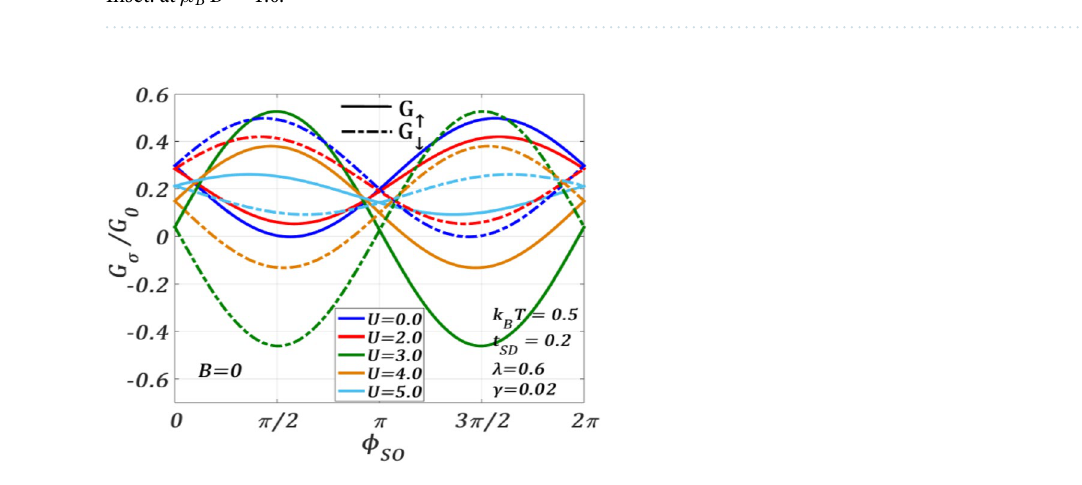
0.5 (cid:31) 0.6, γ 0.02, eV b = = =